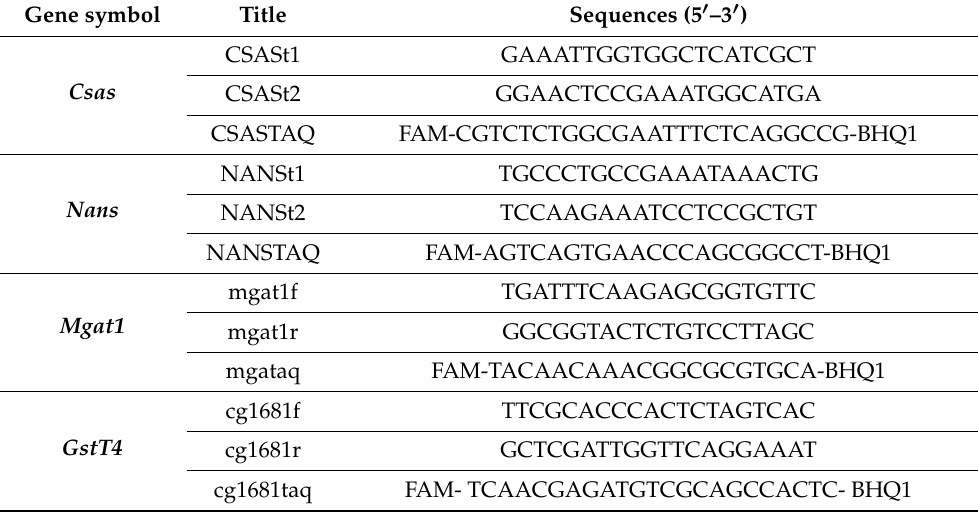
Table A1. Sequences of primer pairs and TaqMan ® probes used in this study. FAM fluorescent dye (6-carboxy fluorescein) was used for labeling oligonucleotides. BHQ1 (Black Hole Quencher-1) is used as a dark